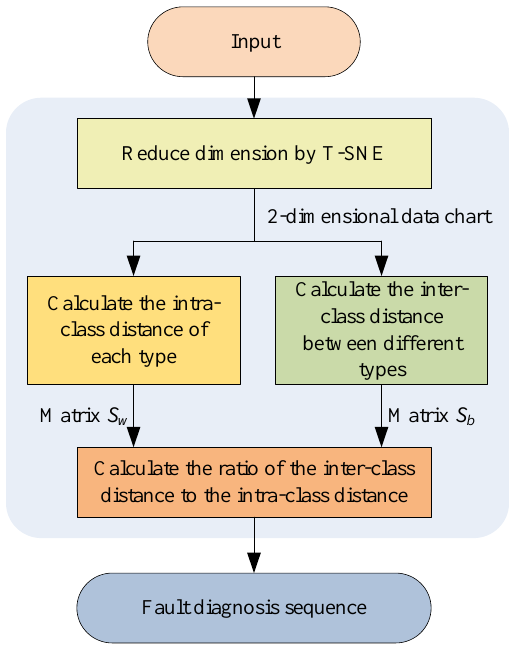
Figure 1. Operation process of the PE method.